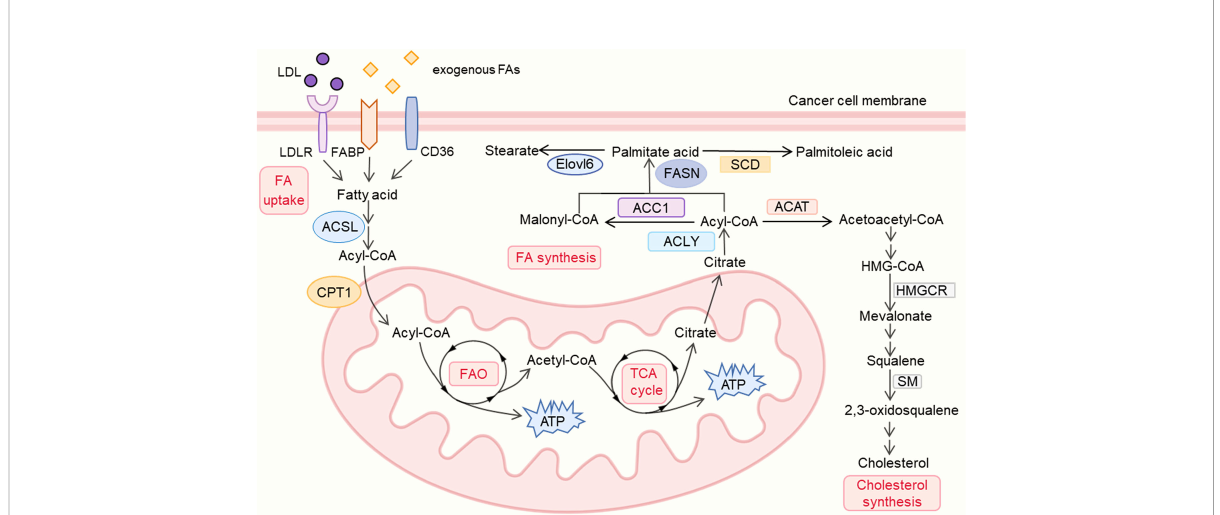
FIGURE 1 lipid metabolism reprogramming in cancer cells. LDL, low density lipoprotein; LDLR, low density lipoprotein receptor; FA, fatty acid; FABP, fatty acid binding protein; ACSL, Acyl-CoA synthetase long chain; CPT, carnitine palmitoyl transferase; FAO, fatty acid oxidation; TCA, tricarboxylic acid cycle; ACLY, ATP – citrate lyase; ACC, Acetyl-CoA carboxylase; FASN, fatty-acid synthase; SCD, Stearoyl-CoA desaturase; Elovl6, Elongation of long-chain fatty acids family member 6; ACAT, Acyl coenzyme A-cholesterol acyltransferase; HMGCR, 3-hydroxy-3-methylglutaryl coenzyme A reductase; SM, squalene